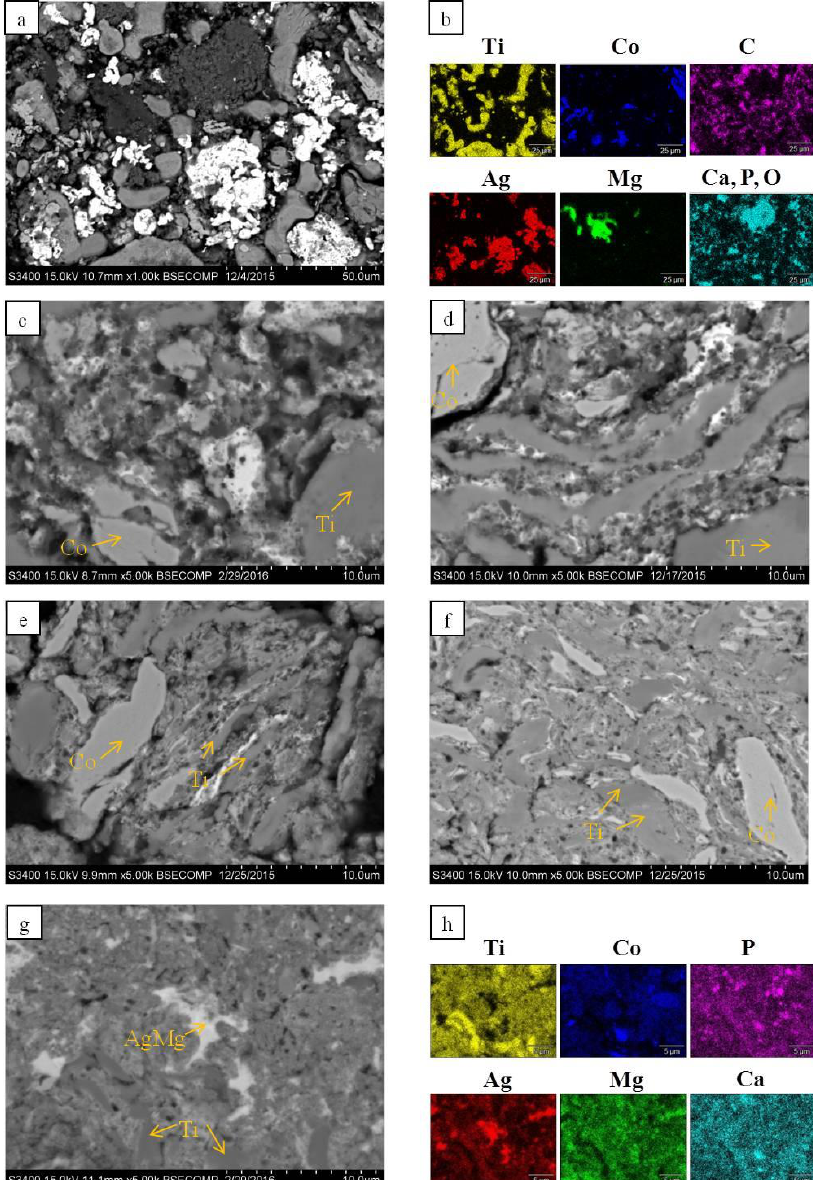
Figure 2. Evolution of the microstructure of the Ti – C – Co – Ca 3 (PO 4 ) 2 – Ag – Mg powder mixtures at X = 24% after the ball rotating mill (BRM) ( a, b ) and MA during 3 ( c ), 5 ( d ), 7 ( e ), 9 ( f ), and 11 ( g,h